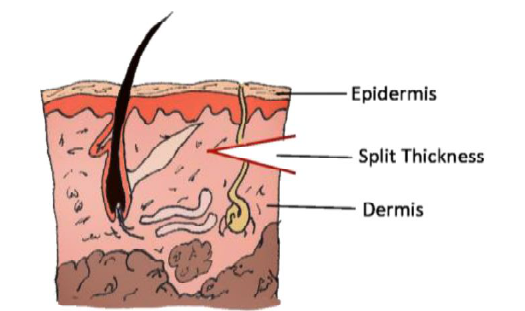
Figure 17. Procuring SSG with dermatome 1